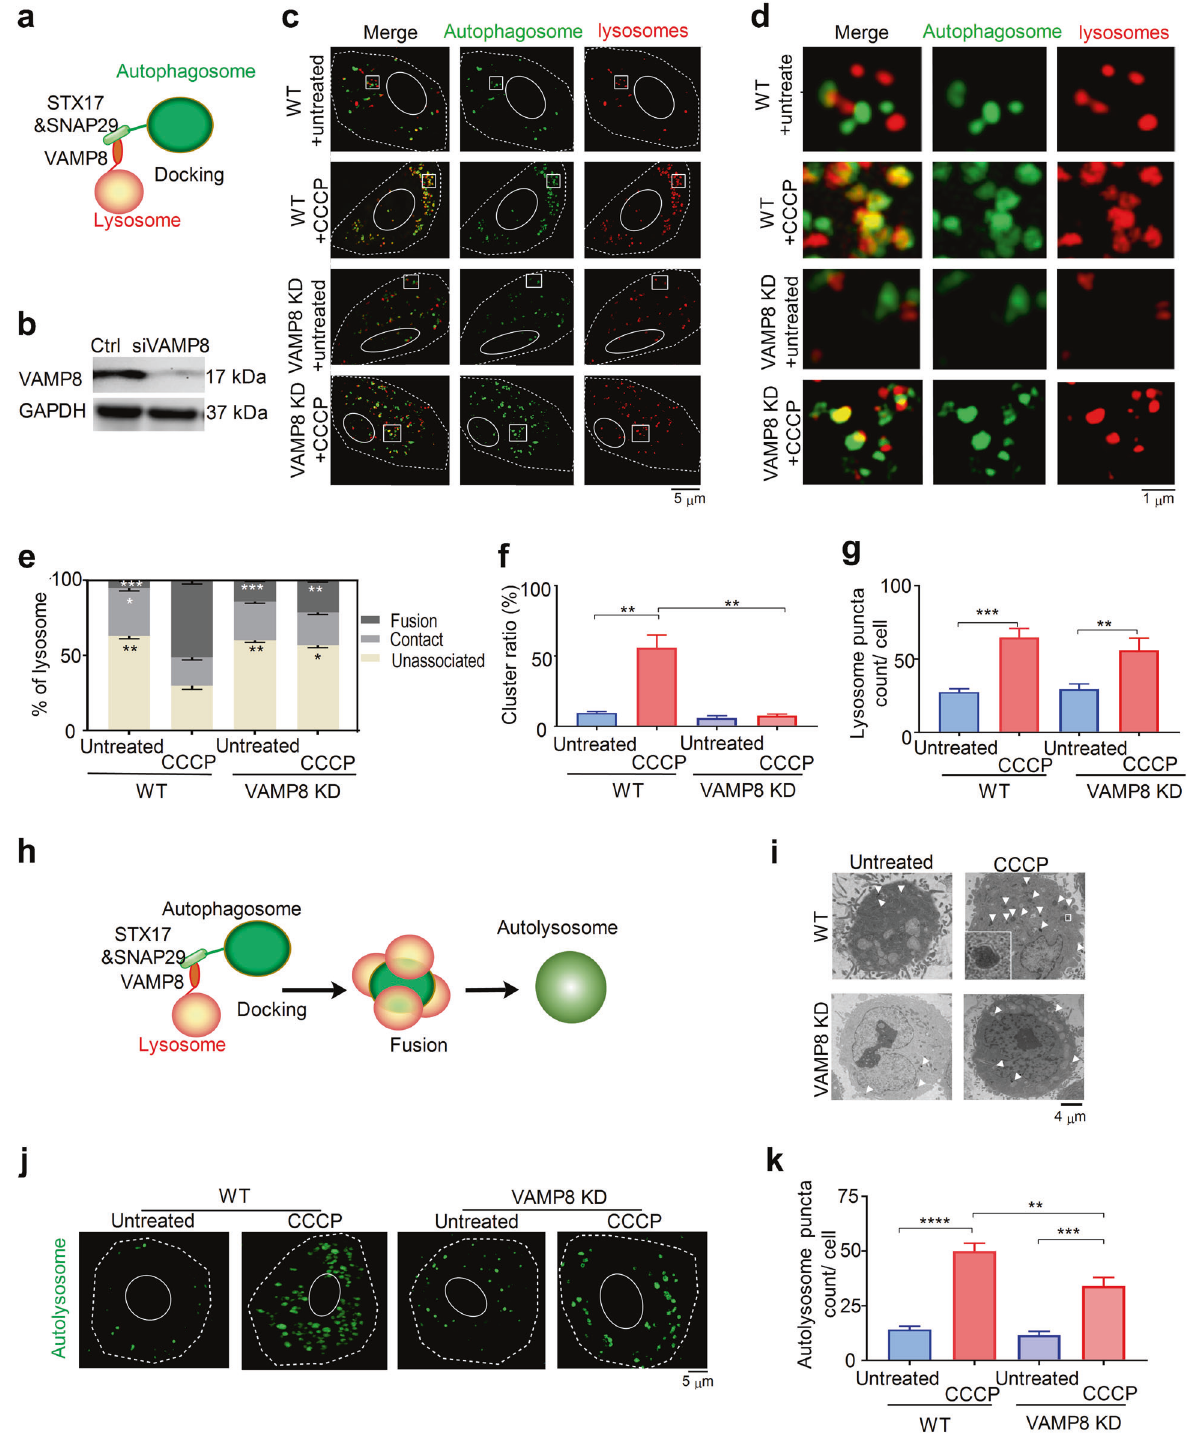
Fig. 3 VAMP8 regulates lysosome – autophagosome interaction. a Schematic representation of VAMP8 in SNARE-mediated lysosome – autophagosome association. b Western blot for detecting VAMP8 protein expression in siRNA gene silencing cells. Cells were transfected with or without siVAMP8 for 48 h, and protein was collected for detecting VAMP8 protein expression. c Overlap of autophagosomes and lysosomes in VAMP8KD and WT HeLa cells with or without CCCP treatment. d Close-up views of lysosome – autophagosome associations for the enlarged region indicated by white rectangles in c . e Percentile distribution of lysosomes unassociated, in contact, and fused with autophagosomes. f Ratio of clustered lysosome clusters to the total number of lysosomes and ( g ) lysosome count in WT and VAMP8KD HeLa cells with or without CCCP treatment. h Schematic representation of VAMP-induced lysosome clustering on an autophagosome. i Autolysosome formation observed by negative stain EM. j SIM image and k count of autolysosome formations in WT and VAMP8KD HeLa cells. Autolysosomes were stained with 100 nM of DALGreen at 37 °C for 30 min, followed by CCCP for 12 h to induce autophagy and then observed under SIM. Data in e , f , g , and k are presented as mean ± SEM, * p < 0.05, ** p < 0.01, *** p < 0.001, **** p <